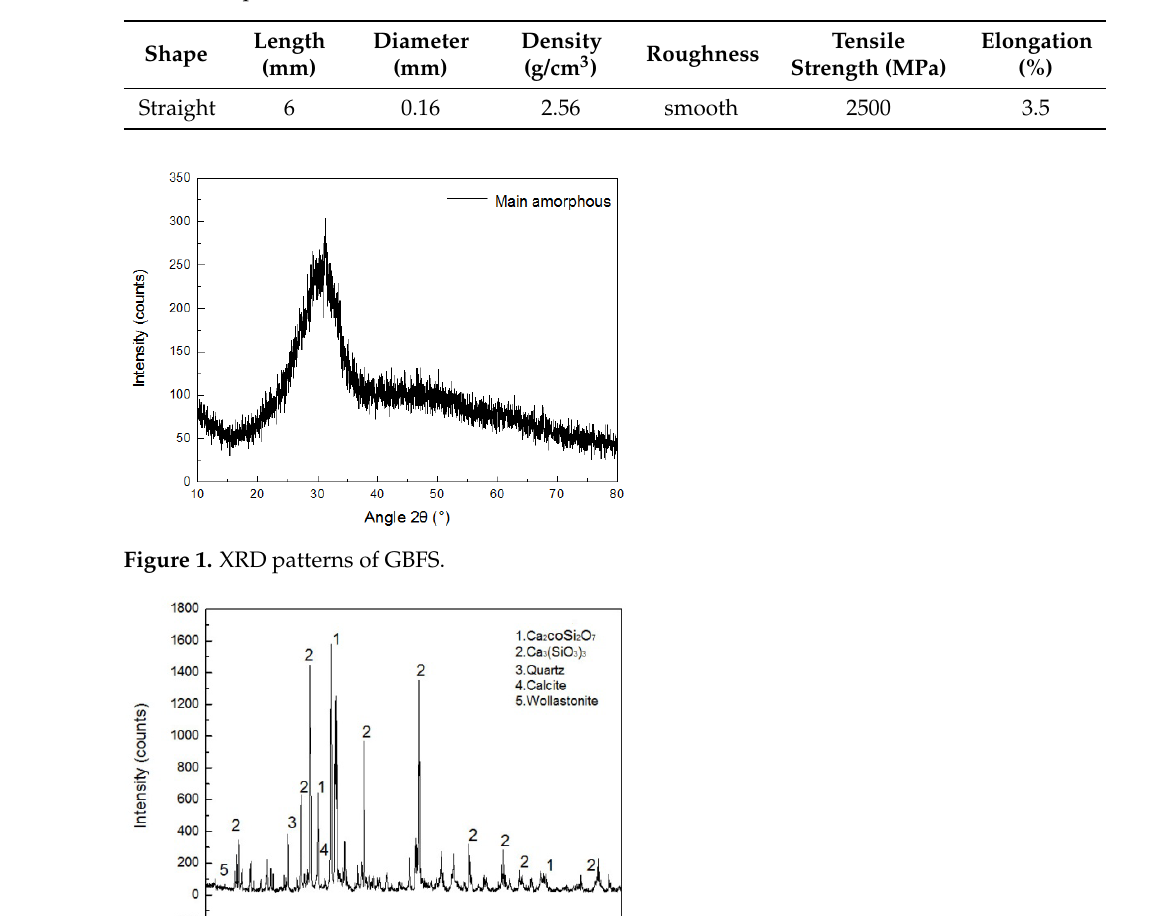
Table 5. Properties of fine sand and sand.